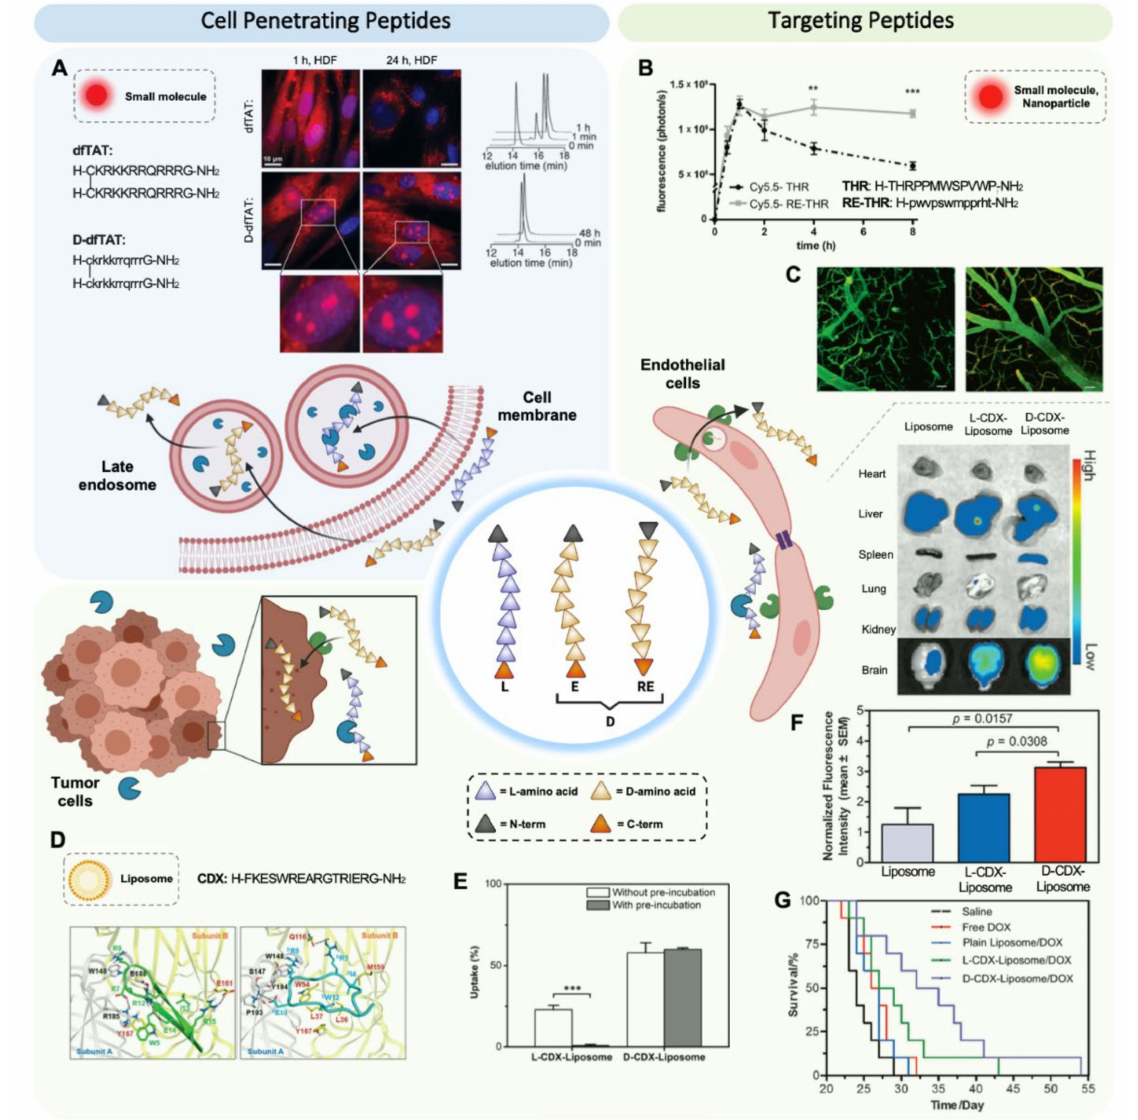
Figure 2. Enantio and retro-enantio isomerization enhance transport and targeting efficiency. ( A ) Cellular distribution of dfTAT and D-dfTAT immediately after delivery and after 24 h. Fluorescence images are overlays of the TMR (red) and Hoechst (blue) emissions (scale bars = 10 µ m) (left). HPLC chromatograms of dfTAT and D-dfTAT upon treatment with trypsin (right), adapted from [37], Elsevier 2017. ( B ) In vivo fluorescence signal of the THR peptide in mice. Deviations represented as standard error mean. Unpaired t student test: ** p < 0.01, *** p < 0.001, adapted with permission from [39], John Wiley & Sons, 2015. ( C ) Intravital two-photon microscopy images of mice brains after injection of “naked” quantum dots (left) or QDs labeled with retro-enantio peptide (right) [39]. ( D ) Representation of the different binding modes of L-CDX (A, green) and D-CDX (B, aqua) with α 7 nAChR. The subunit A of the receptor is shown in grey and subunit B in yellow. Residues involved in binding are represented with sticks, adapted with permission from [15], John Wiley & Sons, 2015. ( E ) Brain capillary endothelial cells uptake of CDX peptide-modified liposomes with and without preincubation in mouse serum. Quantitative cellular uptake by using flow cytometry [15]. ( F ) Ex vivo fluorescence quantification of brain and other organs of mice 8 h after injection of rhodamine B-labeled plain liposomes, L-CDX-liposomes, and D-CDX-liposomes (top). In vivo normalized fluorescence intensity of brain with biodistribution of rhodamine B-labeled D-CDX-liposomes, L-CDX-liposomes, and plain liposomes (bottom) [15]. ( G ) Survival plot of nude mice bearing intracranial U87 tumors. Mice that received four doses of D-CDX or L-CDX-modified liposomes encapsulating doxorubicin (DOX) survived significantly longer than the control groups that received saline